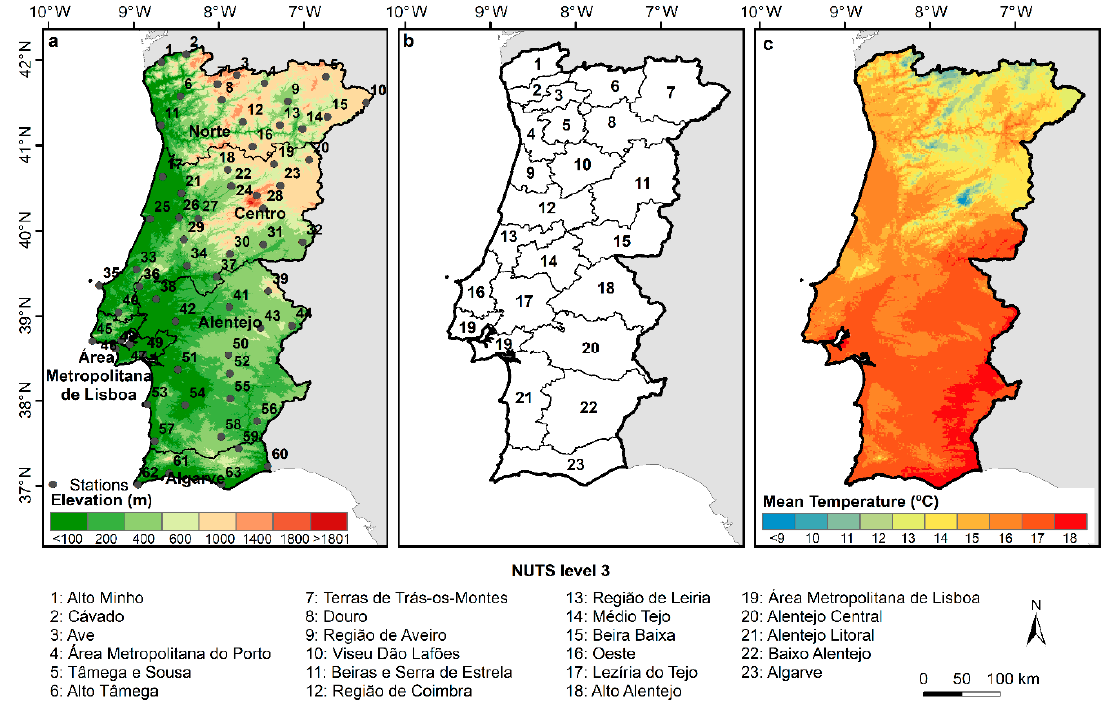
Figure 1. ( a ) Terrain elevation of mainland Portugal and location of the 63 selected meteorological stations. ( b ) Geographical borders of the 23 NUTS (Nomenclature of Territorial Units for Statistics) level 3 (see the list for their designations). ( c ) Annual mean air temperature for mainland Portugal during the period of 2000–2018.